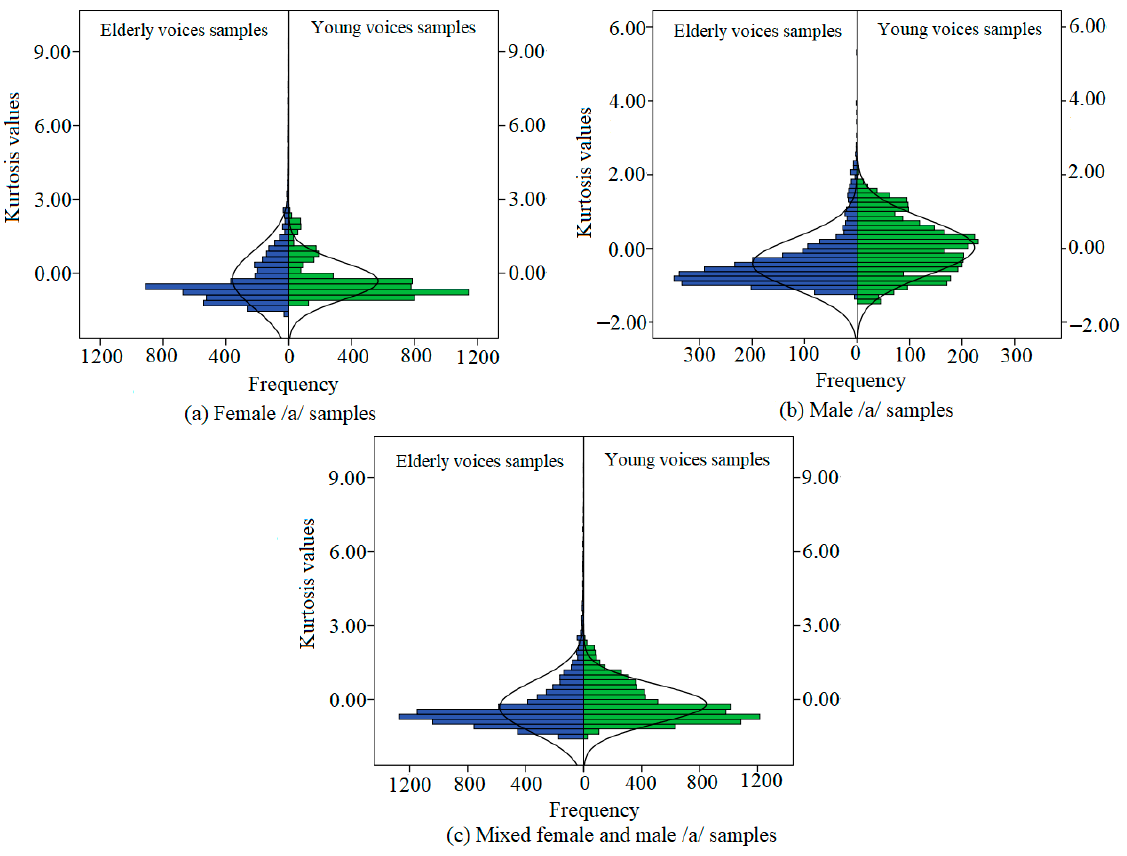
Figure 4. Histograms of kurtosis extracted from elderly and young voices. Table 4. Classification results obtained by MFCC, skewness, and kurtosis parameters and the two different deep learning